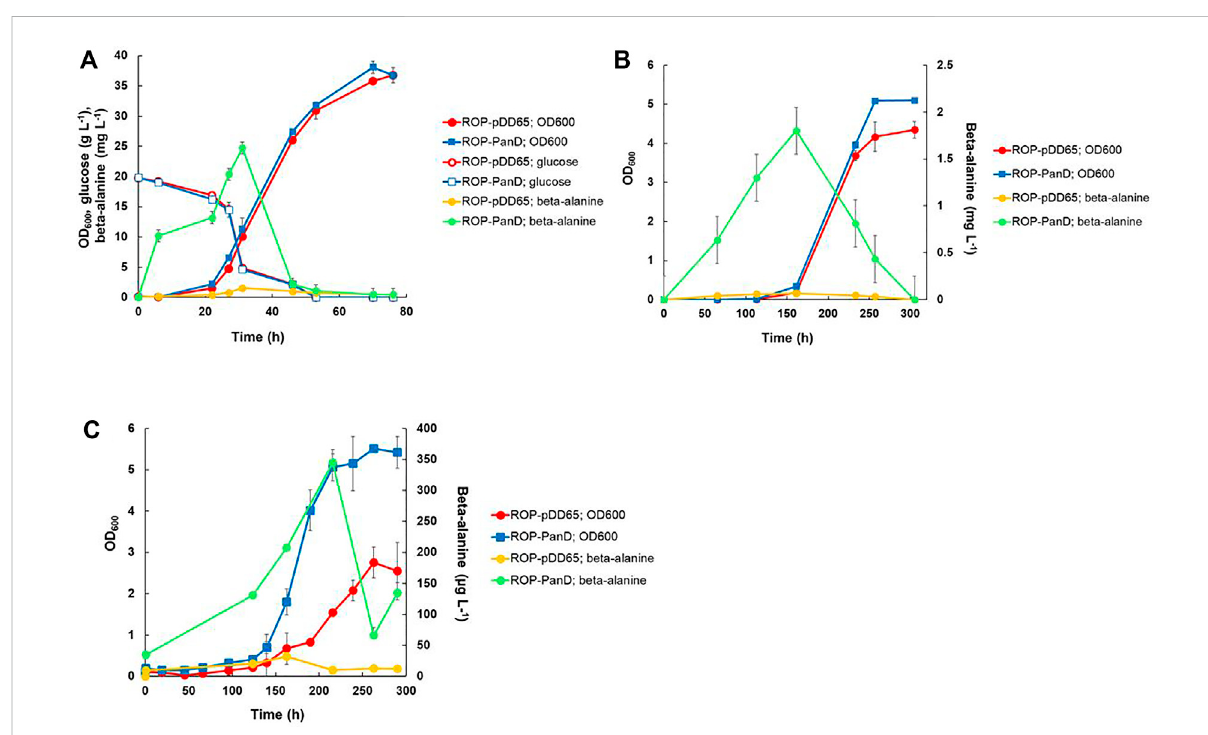
FIGURE 4 Heterotrophicandautotrophicshake- fl askcultivation[ (A,B) ,respectively]and autotrophic electrobioreactor cultivation (C) oftransformants of R. opacus strain ROP-PanD expressing the aspartate decarboxylase gene of C. glutamicum ( panD ). Beta-alanine concentration and cell density (OD 600 ) were followed during the course of the cultivations and displayed as average of biological triplicates with standard deviation. R. opacus pDD65 is included as a control strain